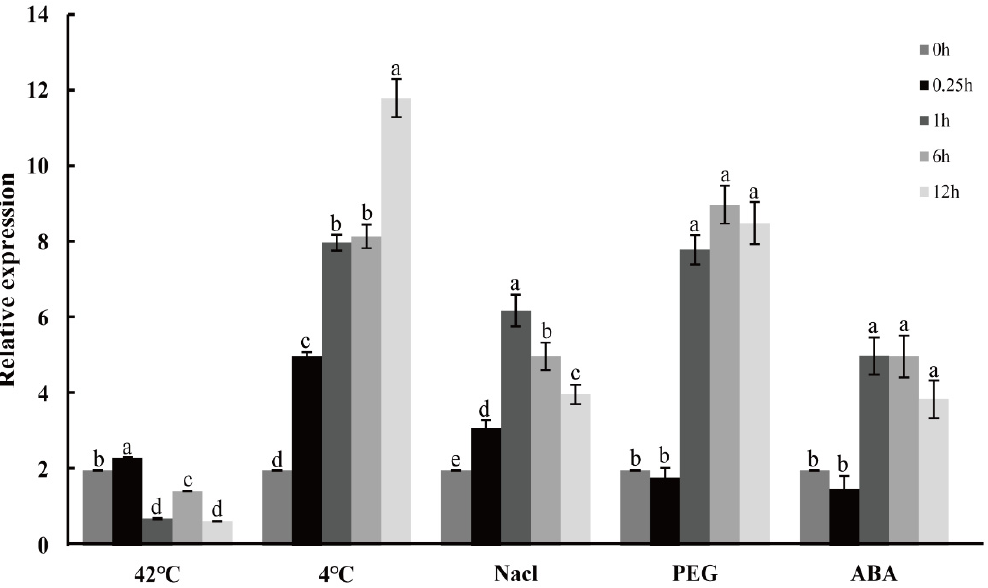
Figure 6. Expression patterns of CpNAC1 in response to abiotic stress. The wintersweet plants were exposed to treatments at 42 °C, 4 °C, 1 M NaCl, 30% PEG6000, and 50 µM ABA. Data represent means of three biological repeats ± standard deviations (SDs). Different lowercase letters indicate significant differences ( p < 0.05).